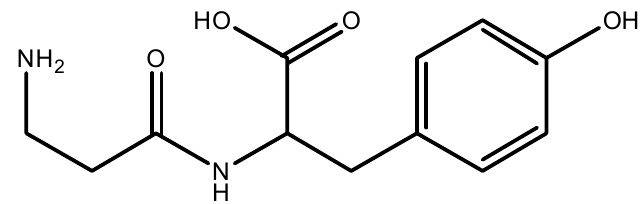
Figure 1. Molecular structure of the dipeptide β -alanyl-tyrosine.